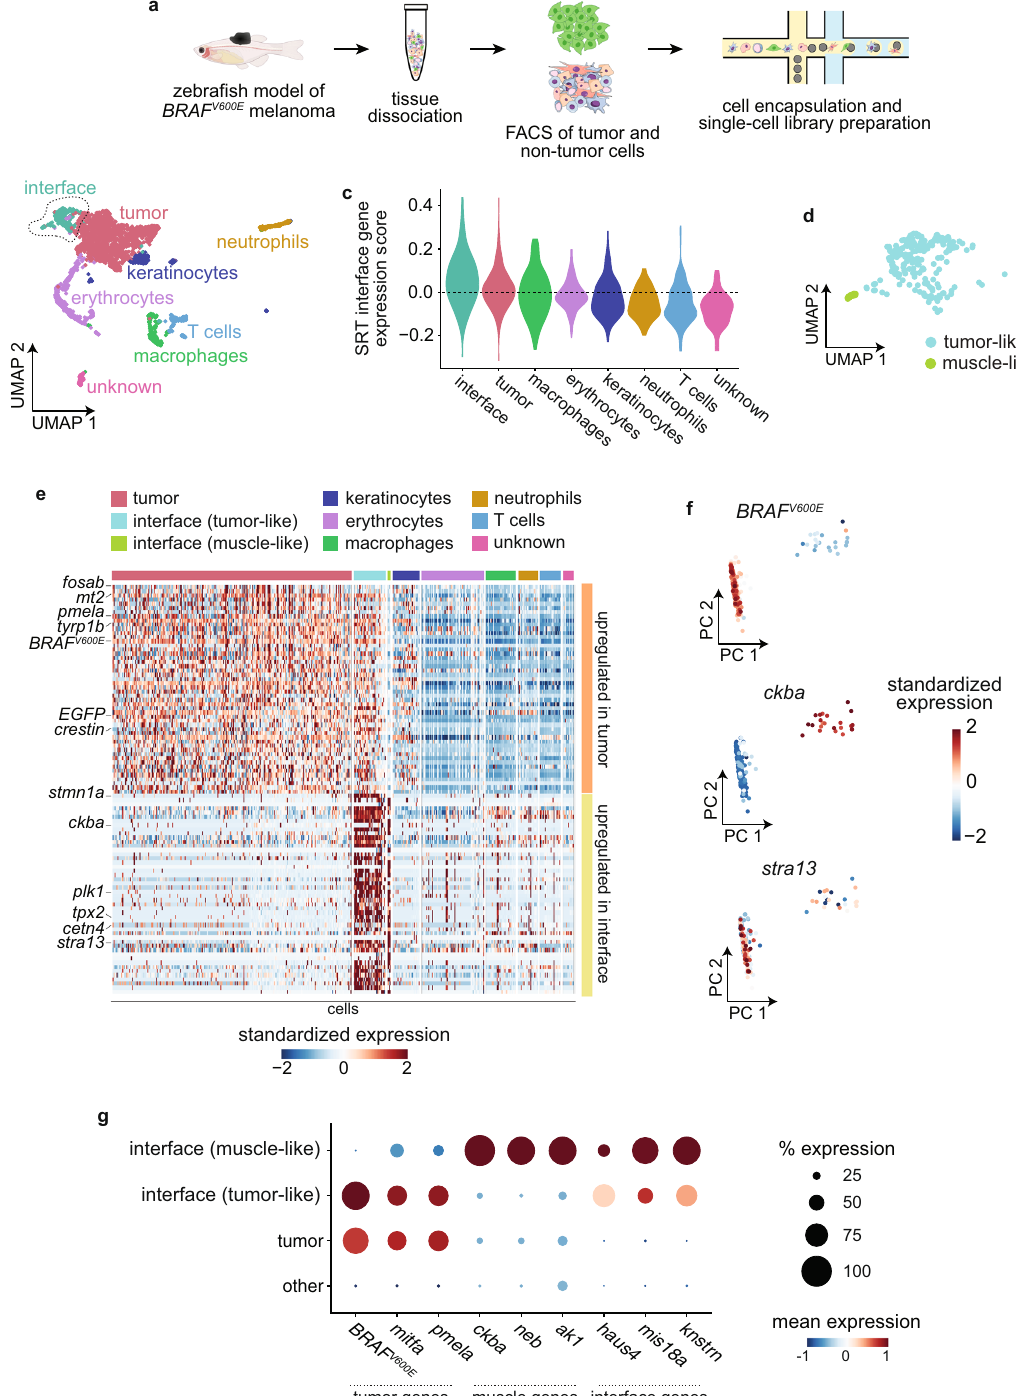
Fig. 3 The tumor – microenvironment interface is composed of specialized tumor and muscle cells. a Schematic showing scRNA-seq experiment work fl ow. b UMAP dimensionality reduction plot for 2889 cells sequenced as in a . Cluster/cell type assignments are labeled and colored. c Expression score per cell (scRNA-seq) for average expression of interface marker genes from the SRT interface cluster. d Inset of the outlined interface cluster in b showing the two interface subclusters. e Heatmap showing expression of the top 50 genes upregulated in the tumor cell cluster (top, orange) and interface cell cluster (bottom, yellow). Selected genes are labeled. f Principal component analysis of cells in the interface cluster, scored for expression of the tumor marker BRAF V600E , the muscle marker ckba , and the centromere gene stra13 . Scores for principal components 1 and 2 are plotted. Cells are labeled by standardized expression of the indicated genes. g Dot plot showing expression of tumor and muscle markers. The size of each dot corresponds to the percentage of cells in that cluster expressing the indicated gene, and the color of each dot indicates the expression